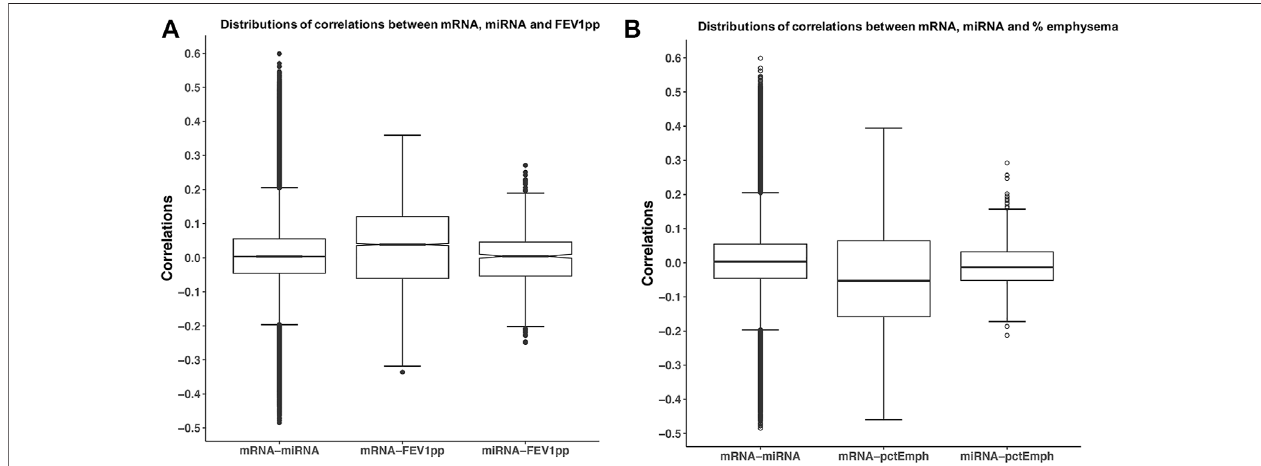
FIGURE 2 | Correlations of mRNA, miRNA, and phenotypes. The miRNA and mRNA data were partially adjusted as discussed in method session. Each pair of correlations among mRNA and miRNA, mRNA, and phenotype. (A) FEV 1 pp or (B) percent emphysema was calculated. Boxplots illustrate the distribution of pair-wise correlations.